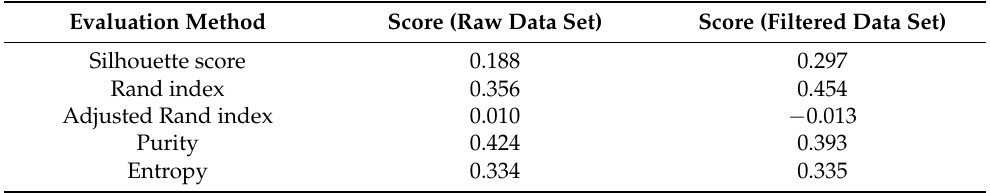
Table 1. The evaluation results for the time-series clustering.